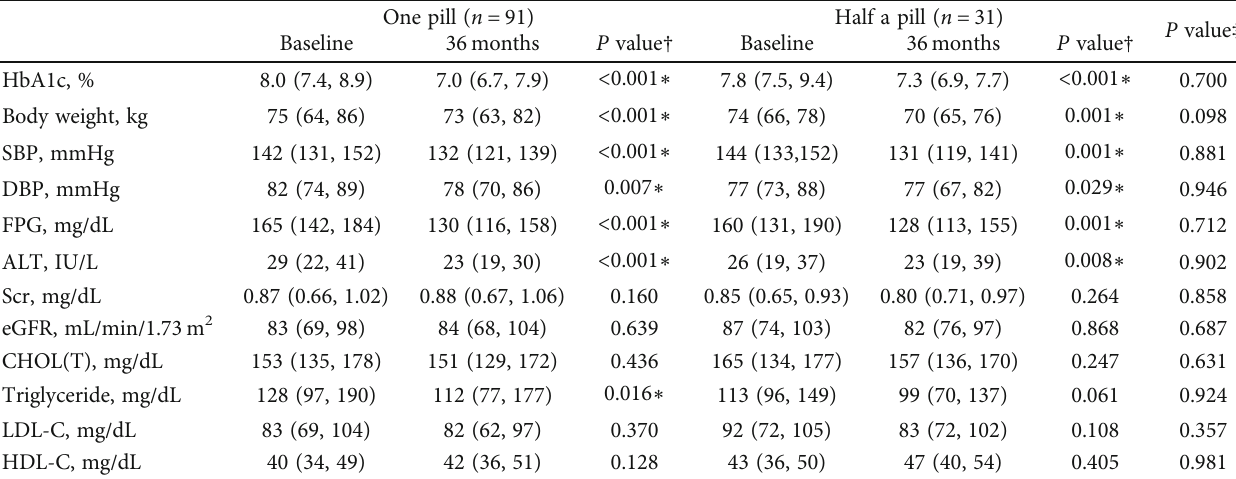
Table 4: Comparison changes in clinical parameters from baseline between di ff erent doses. One pill ( n = 91